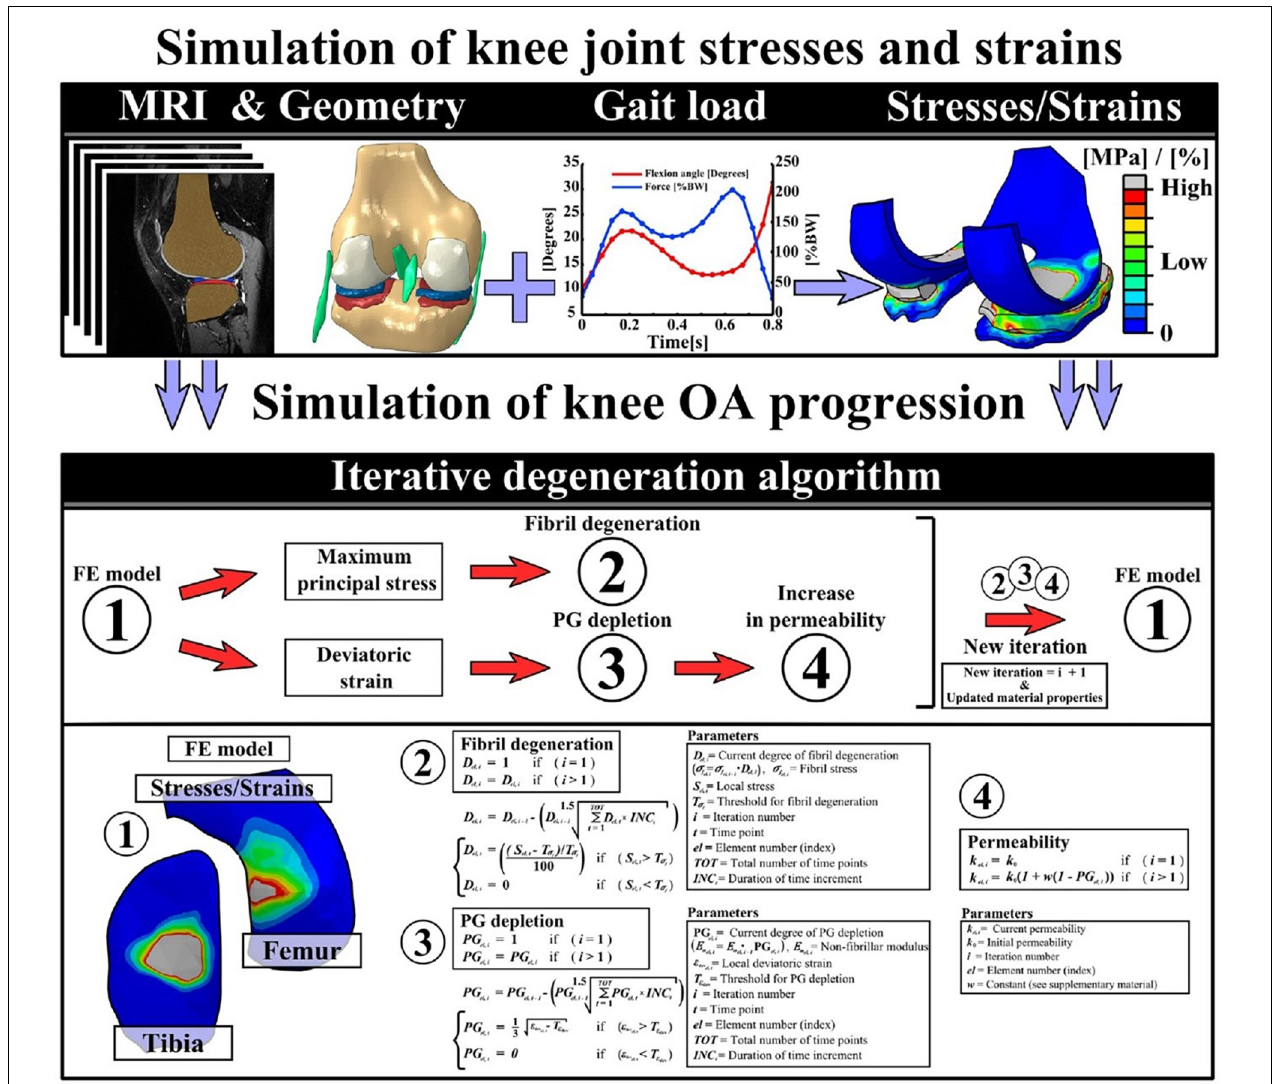
FIGURE 4 | This figure presents the detailed workflow followed to implement an iterative degeneration algorithm. The top row describes the steps followed to develop the FE model to simulate knee joint stresses and strains. The middle row shows the different components of articular cartilage that are considered to